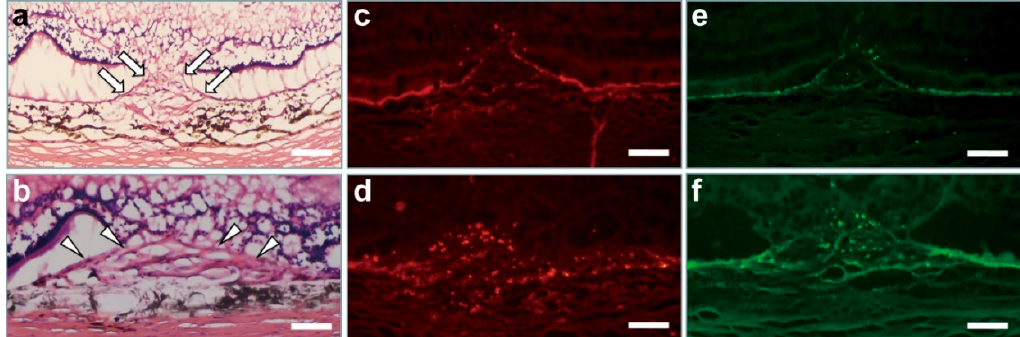
Figure 1. Hematoxylin and eosin and immunofluorescence staining of laser-induced CNV lesions. Typical samples of hematoxylin and eosin-stained sections show that chrysin-treated eyes ( a ) had much smaller CNV lesions (arrows) than did control eyes (arrowheads) ( b ). Immunofluorescence staining using mouse monoclonal hypoxia-inducible factor-1 alpha and rabbit polyclonal anti-rat vascular endothelial growth factor antibodies revealed minimal fluorescence in chrysin-treated eyes ( c , e ) compared with the enhanced fluorescence in control eyes ( d , f ). Scale bar = 50 µ m. CNV, choroidal neovascularization.